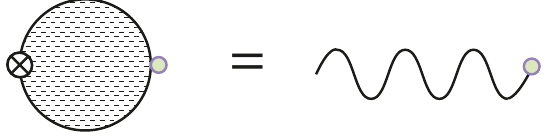
Figure 6 . The (cid:1) c 2 vertex sources the composite metric as a cosmological